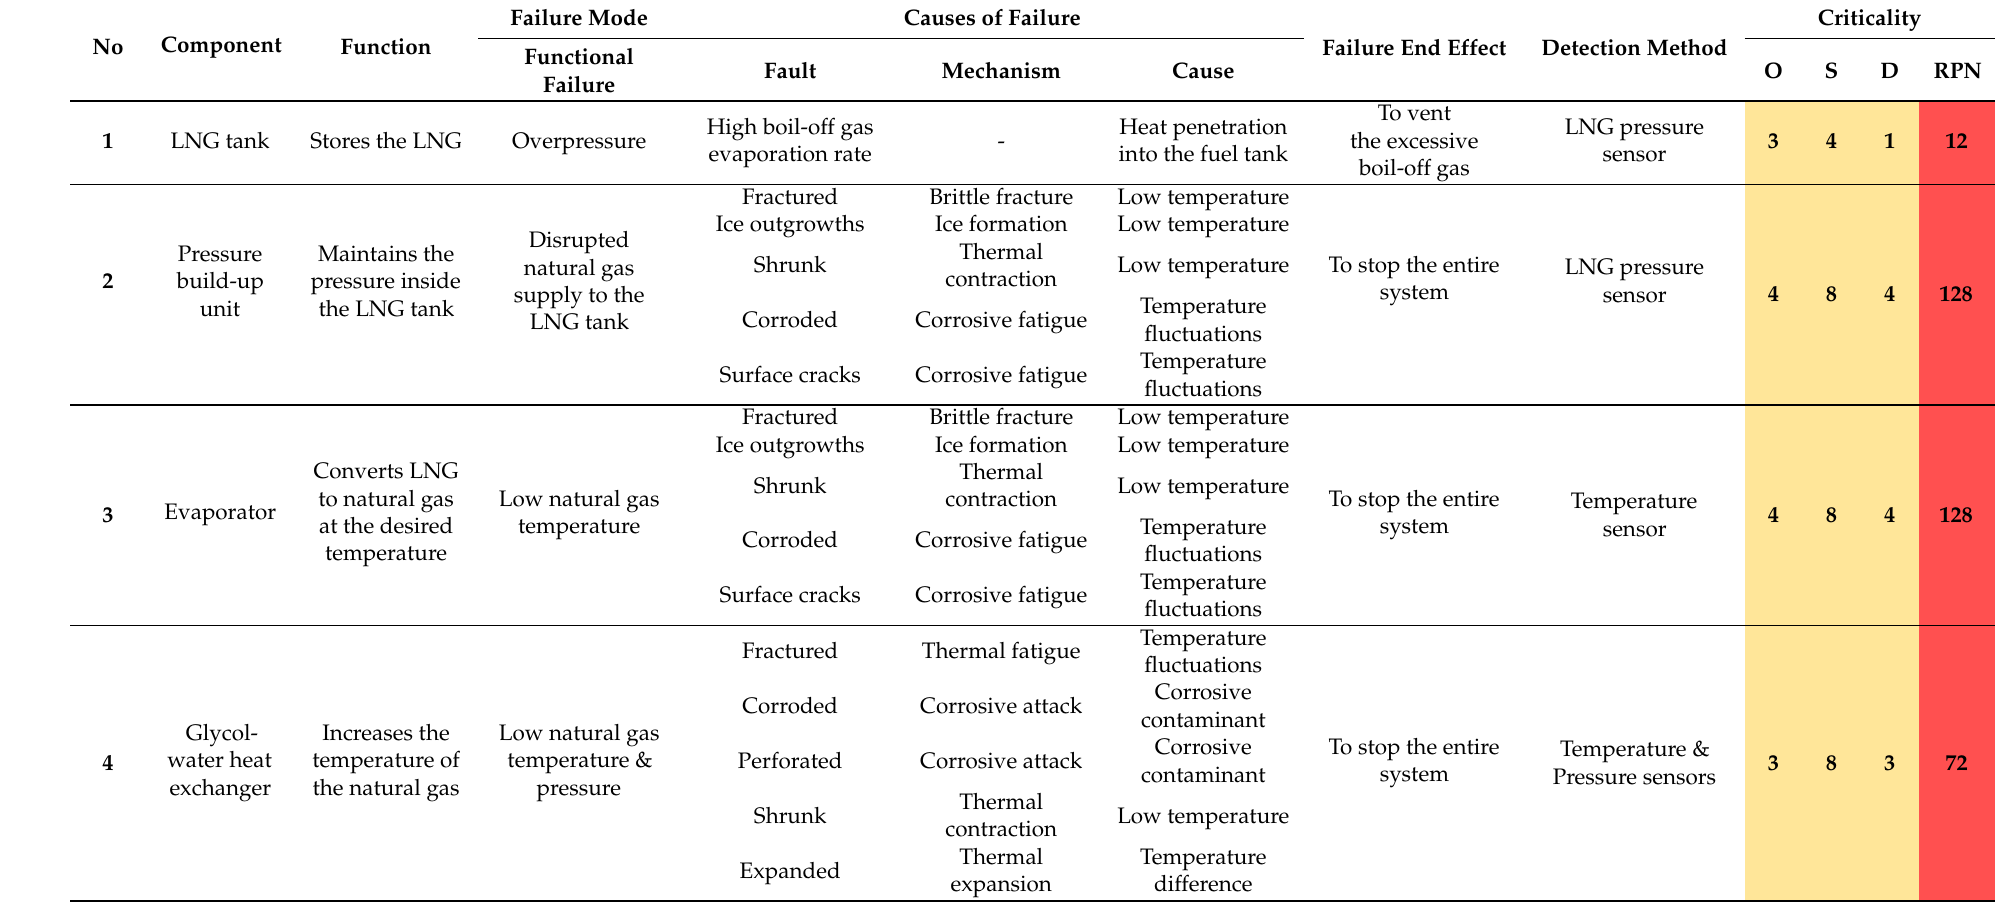
Table 7. FMECA table as generated from MADe indicating the Risk Priority Number (RPN) of each system component failure mode (O: Occurrence; S: Severity; D: Detectability).